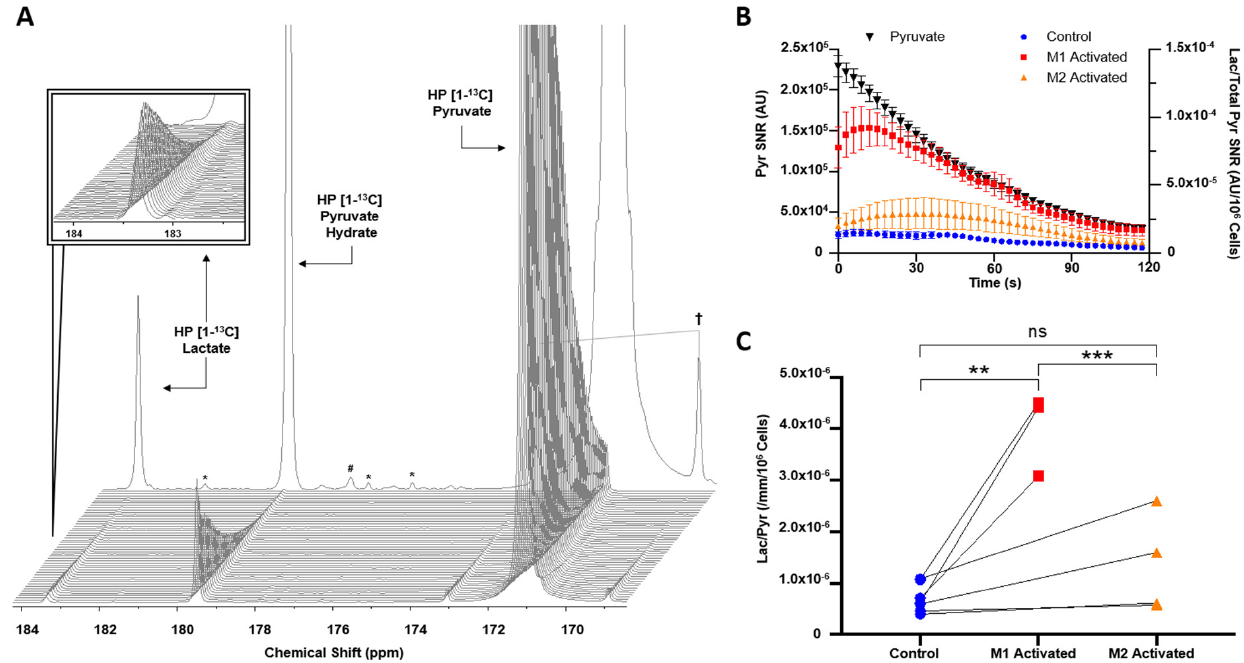
Figure 2. HP [1- 13 C]lactate production is differentially increased by M1/M2 macrophage activation. ( A ) Dynamic spectra acquired at 1.47 Tesla post HP [1- 13 C]pyruvate injection into M1-activated J774a.1 macrophages, and corresponding sum spectra over 100 TRs in background. Insert shows HP [1- 13 C]lactate dynamics. († symmetric splitting of pyruvate due to 1.1% 13 C natural abundance in C2 position; # alanine peak; * contaminants). ( B ) Signal to noise ratio (SNR) of HP [1- 13 C]pyruvate decay from all injections (black, left y -axis) and HP [1- 13 C]lactate production (right y -axis) in M1-activated (red), M2-activated (orange), and control cells (blue) over 120 s. ( C ) HP lactate-to-pyruvate ratios measured in controls (blue) and their activation pairs (M1-activated red, M2-activated orange) ( Non Significant NS : p = 0.1866, ** p < 0.01, *** p < 0.001).